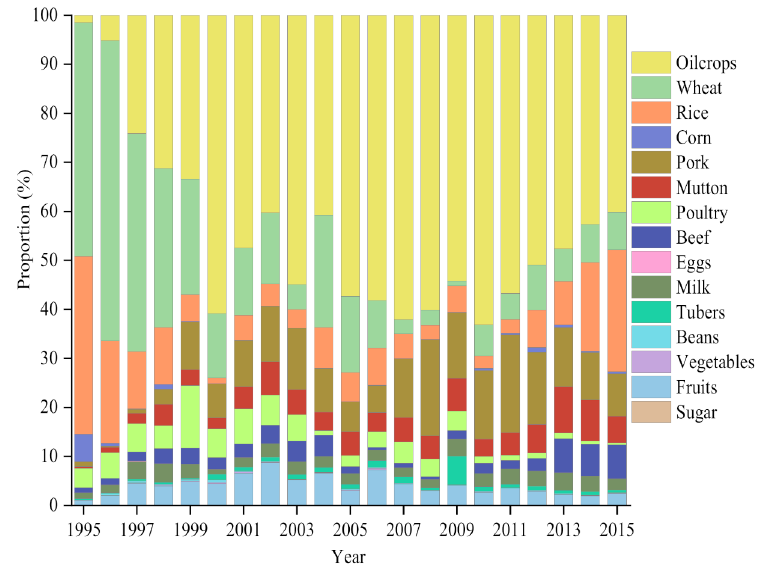
Figure 6. Compositions of GHG emissions embodied in imports by the type of agricultural products during